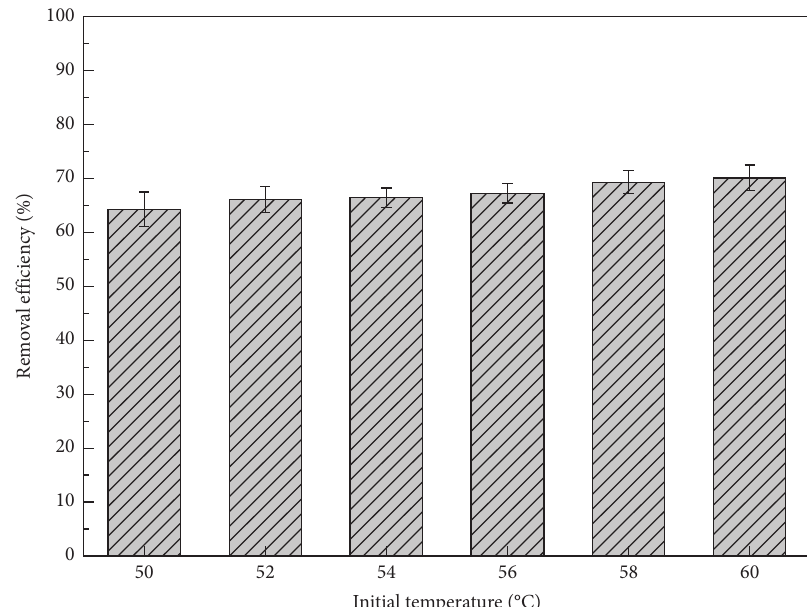
Figure 7: Effect of initial temperature on the removal efficiency of sulfuric acid aerosol.